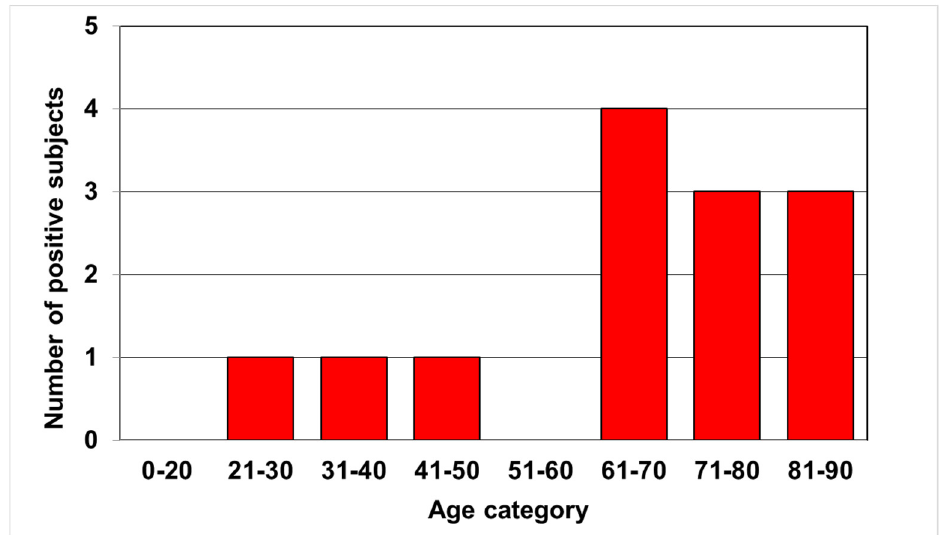
Figure 2. Distribution of positive anti ‐ Anaplasma antibody results by age. The difference in the fre ‐ quency of positive results between the groups of 60 years and younger and 61 years and older was found to be statistically significant (two ‐ tailed Fisher’s exact test, p <0.05).